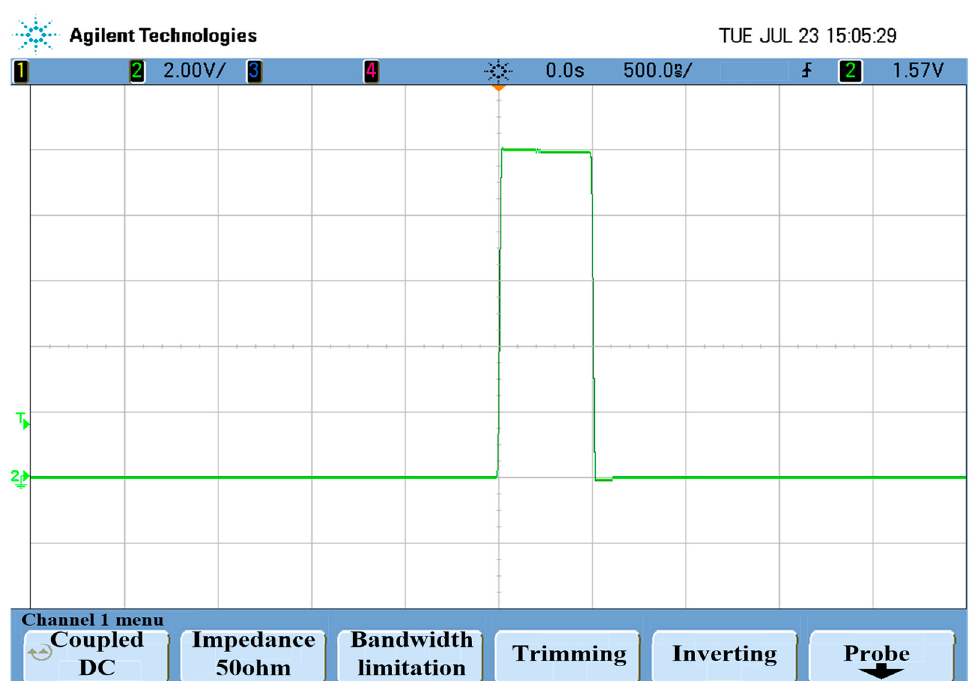
Figure 14. Exciting signal waveform in experiment